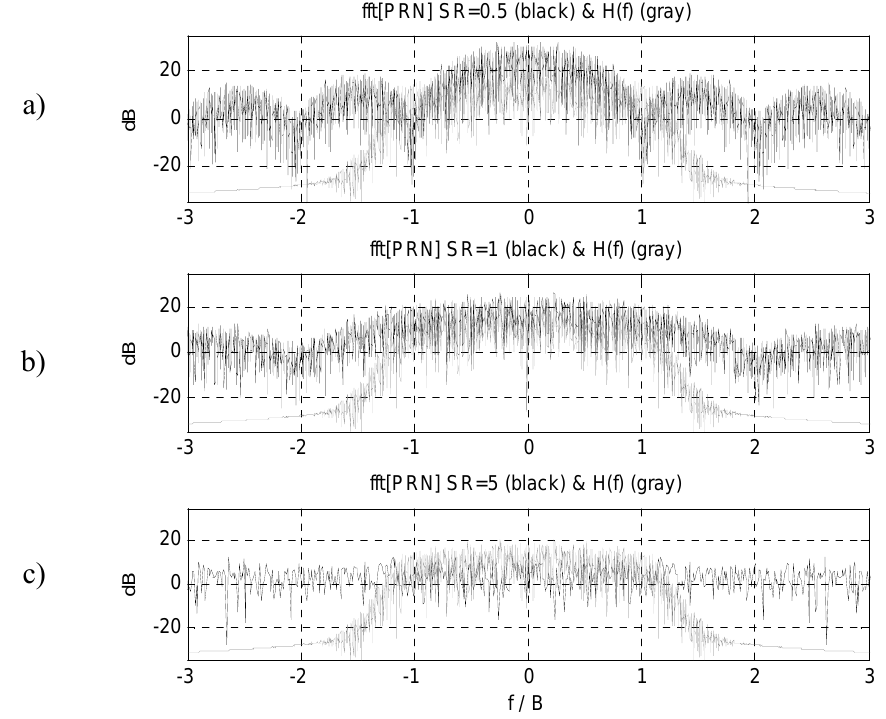
Figure 2. Equivalent low-pass spectrum of PRN sequence (black) with different Symbol Rates (SR) and H(f) estimated from noise (gray). Positive and negative frequencies plotted normalized to the